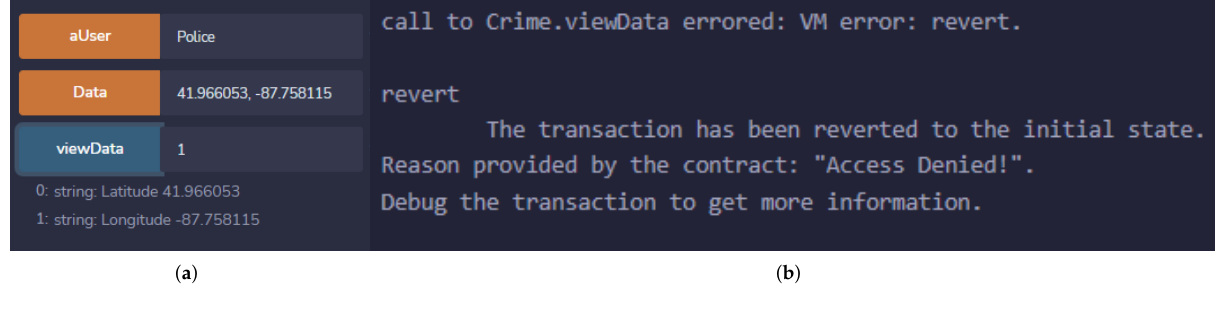
Figure 9. Prototype application for finding the location of the nearest police quarters. ( a ) Data accessed by an authorized official. ( b ) Warning message for an